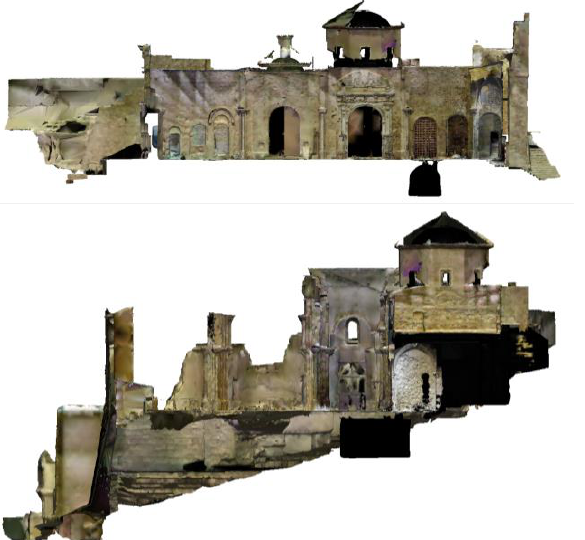
Figure 6. Elevation interior of the building sectioning by the Roman Cistern (above) and by side chapels (below).